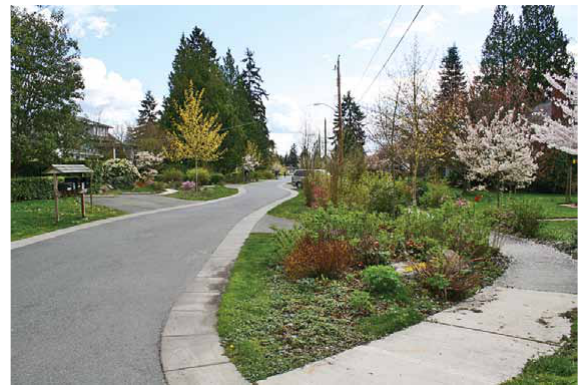
fig. 5. lizard Garden in Zurich